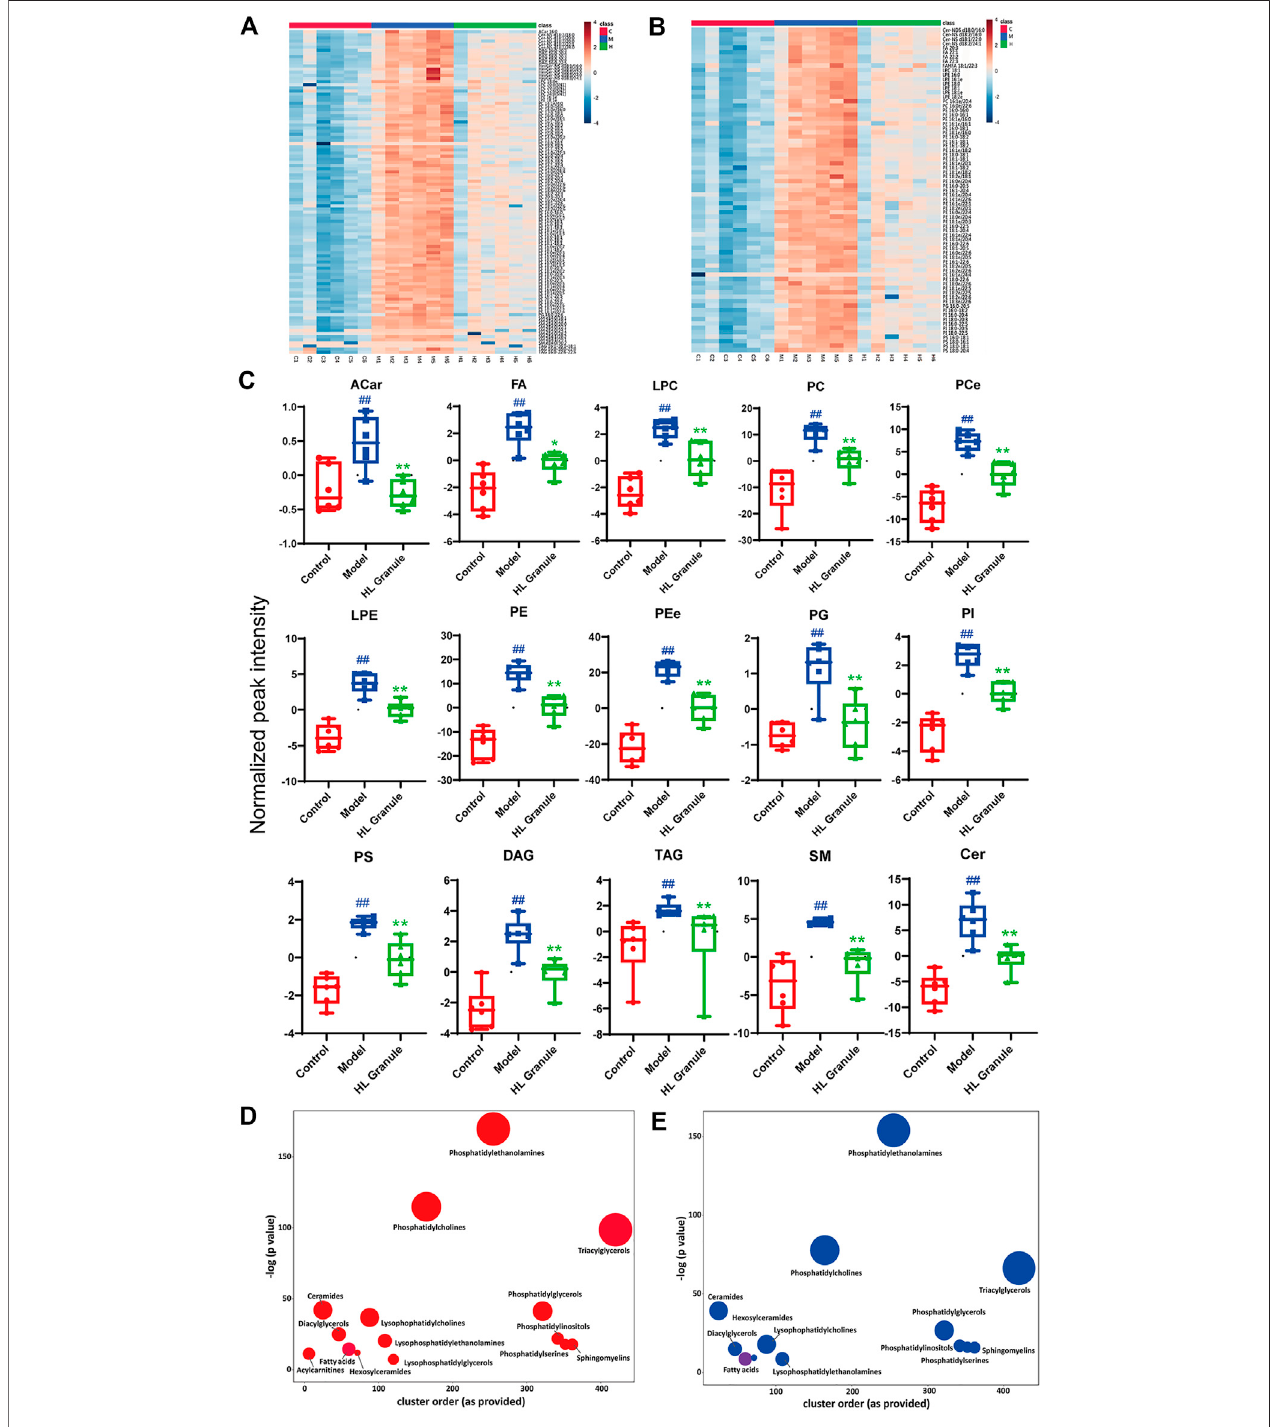
FIGURE 4 | Summary of differentially expressed lipids. (A, B) Heatmaps of differentially expressed lipids in positive (A) and negative (B) ion mode, n (cid:2) 6. Each columnrepresentsasample,eachrowrepresentsadifferentiallipid,andeachblockrepresentsthecorrespondingintensityvalue,redtoblueofthecorrespondinglipidin each sample, representing the value from large to small. Differentially expressed lipids were reversed in HL Granule group compared to model group (FDR < 0.05). (C) Box-whiskerPlotofdifferentiallyexpressed lipidsubclasses,inpositiveandnegativeionmode, n (cid:2) 6 (D,E) Enrichmentstatisticsplotofsigni fi cantlyregulatedlipids betweenmodelandcontrolgroups (D) aswellasHLGranuleandmodelgroups (E) , n (cid:2) 6.Eachnodere fl ectsasigni fi cantlyaltered clusteroflipids.Enrichment p -values are given by the Kolmogorov-Smirnov-test. Node sizes represent the total number of lipids in each cluster set. The node color scale shows the proportion of increased (red) or decreased (blue) compounds. Purple-color nodes have both increased and decreased lipids. Results in (C) extends from 25th to 75th percentile and the line represents the median, the Mann-Whitney test was used between two groups, n (cid:2) 6; ## p < 0.01 compared to control group; ** p < 0.01, compared to model group.